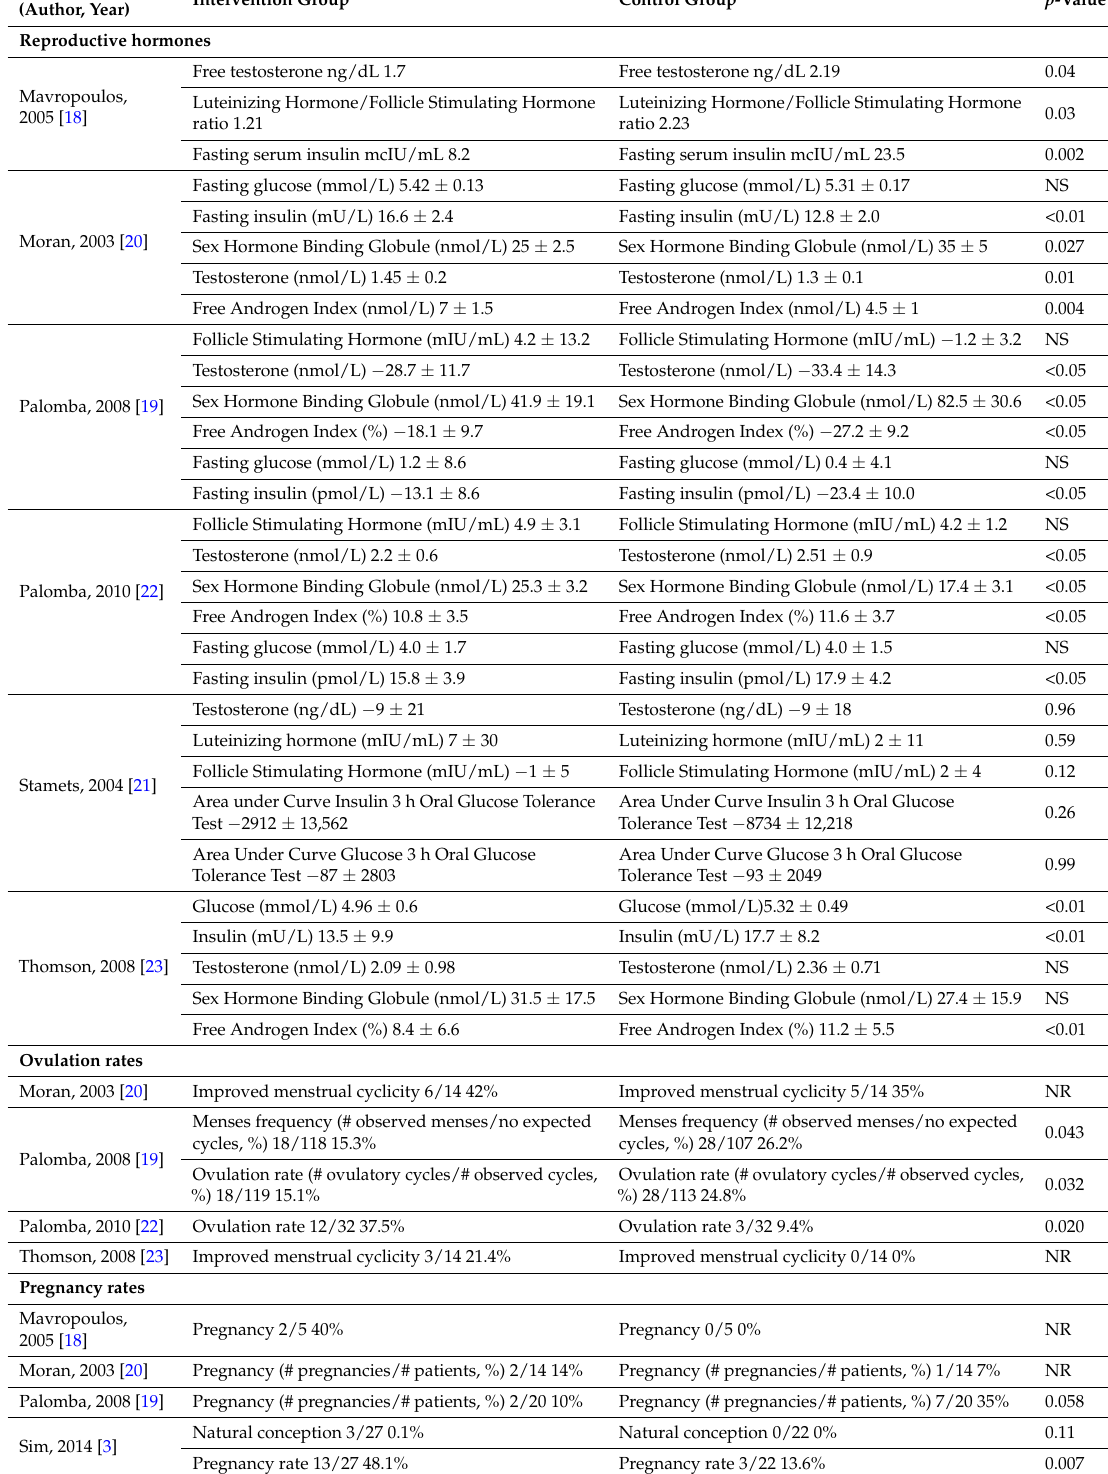
Table 3. Fertility outcomes of included